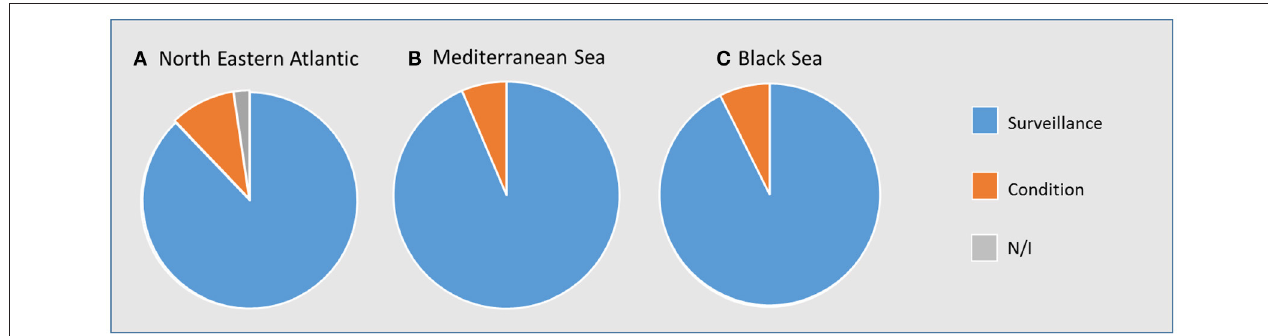
FIGURE 2 | Types of monitoring: condition and surveillance monitoring in the (A). North Eastern Atlantic, (B) . Mediterranean Sea and (C) . Black Sea. N/I, not identified.